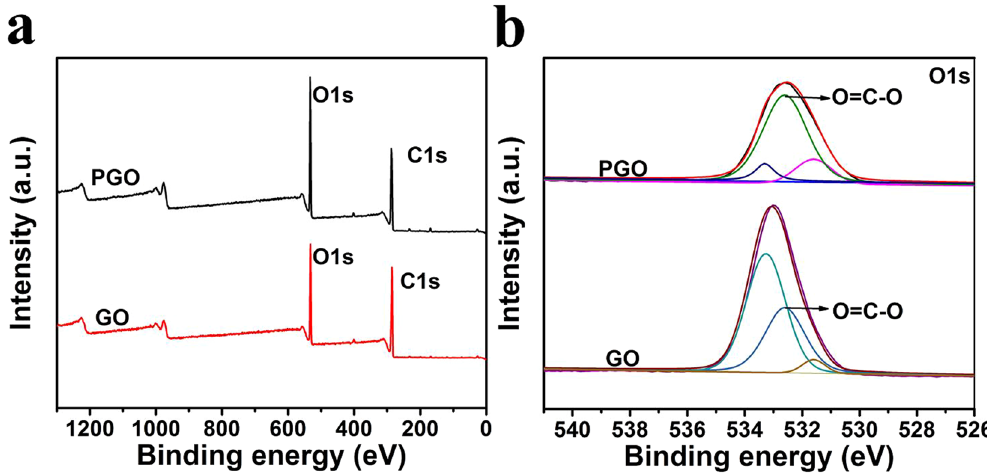
Figure 4. XPS survey of GO and PGO ( a ). O1s XPS of GO and PGO ( b ).